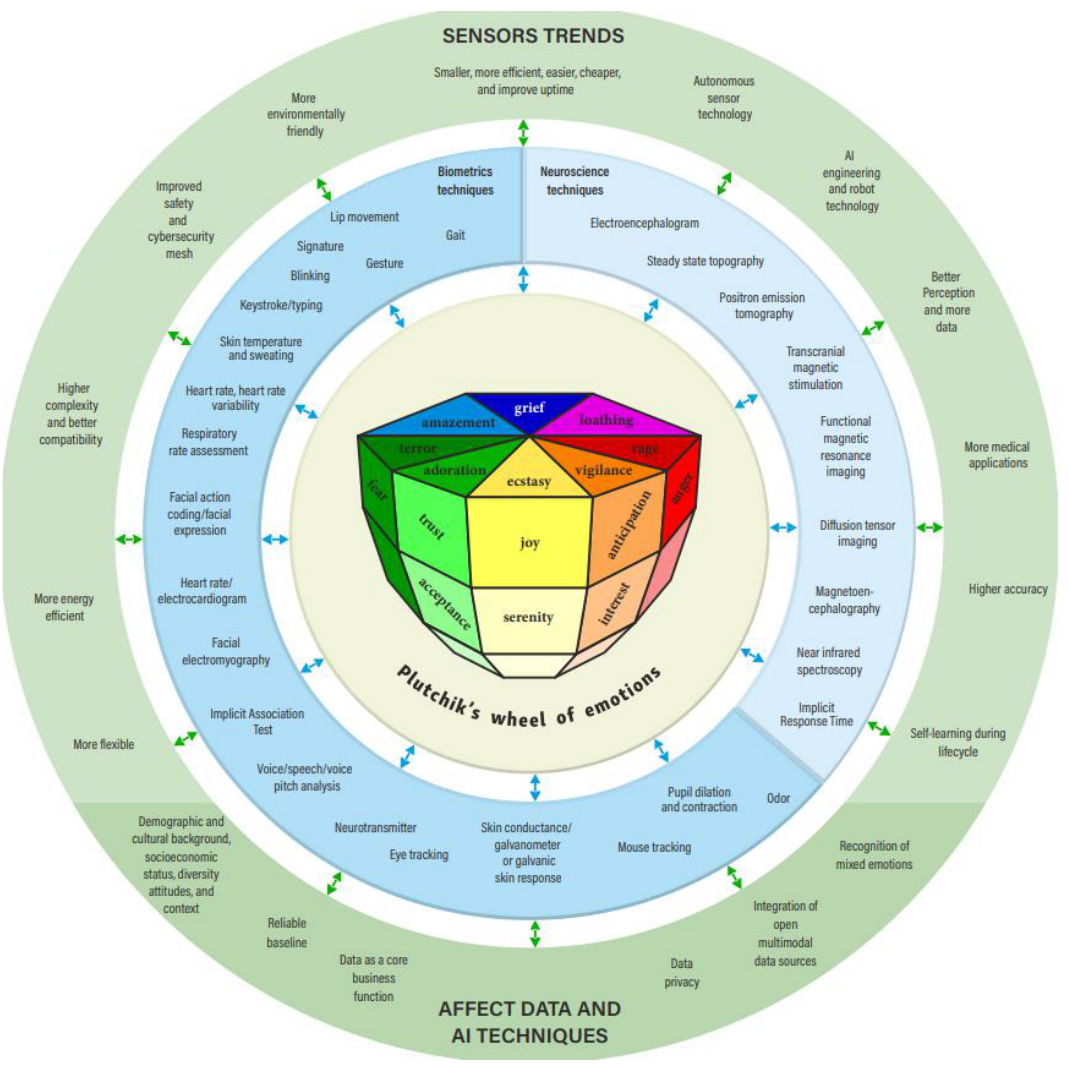
Figure 1. Plutchik ’ s wheel of emotions, biometrics and neuroscience sensors, and trends. Figure 1. Plutchik’s wheel of emotions, biometrics and neuroscience sensors, and